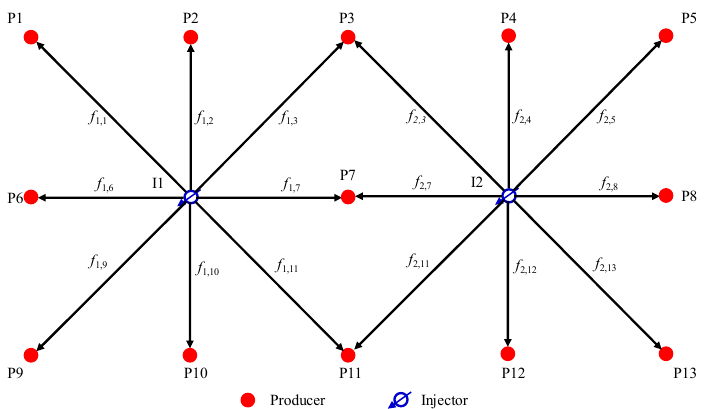
Figure 2. The schematic diagram of the connection flow line of the reverse nine-point injection– production well pattern.